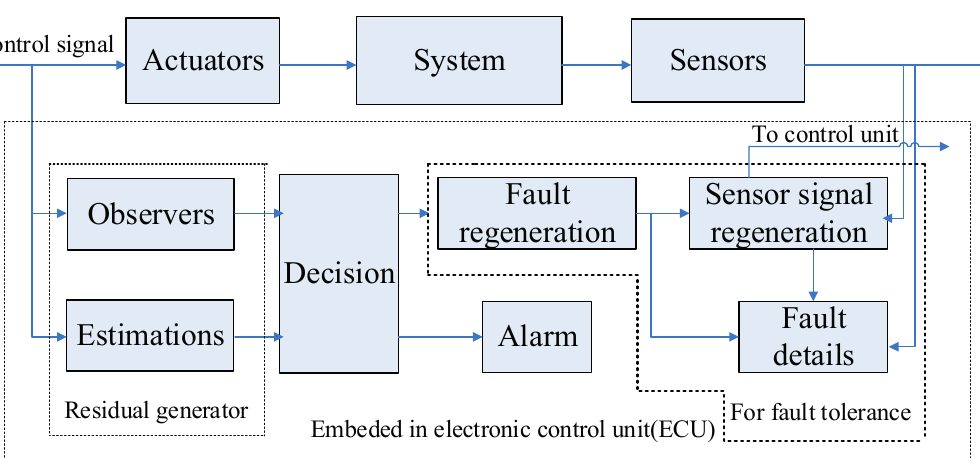
Figure 10. The fault monitoring